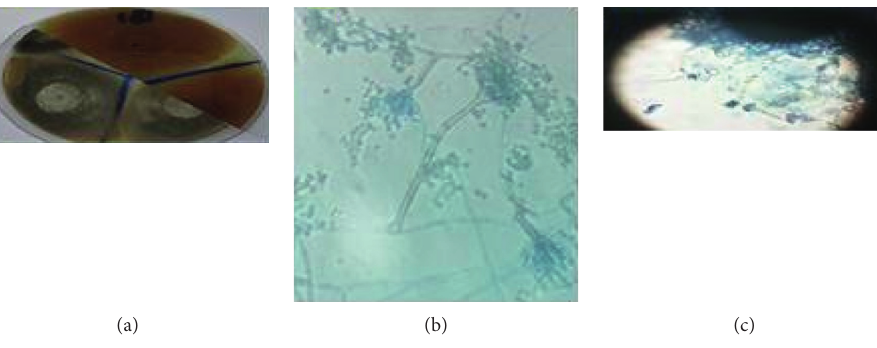
Figure 4: Aspergillus nidulans found in burn